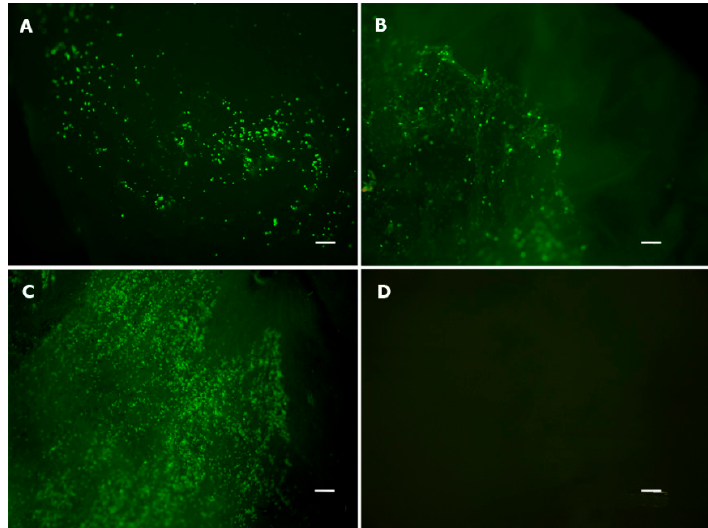
Figure 3. Cell viability assay. Live/Dead Viability/Cytotoxicity Kit for mammalian cells (Invitrogen, Carlsbad, CA, USA). ( A ) One-day cell culture; ( B ) three-day cell culture; ( C ) seven-day cell culture; and ( D ) control scaffold without cells to exclude natural collagen fluorescence. Live cells are green (objective, ×4). Scale bars represent 200 μ m.